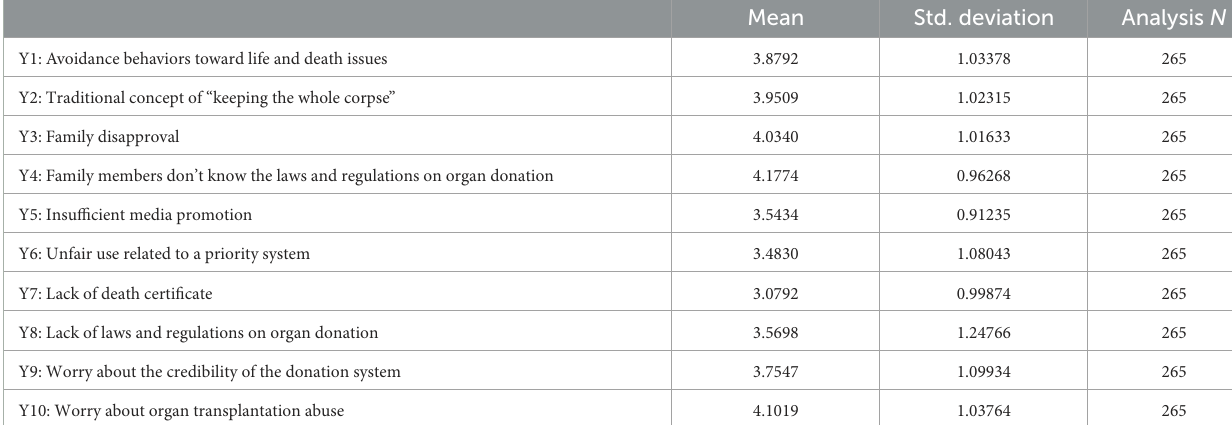
TABLE 5 Descriptive statistics (unwillingness to donate organ).